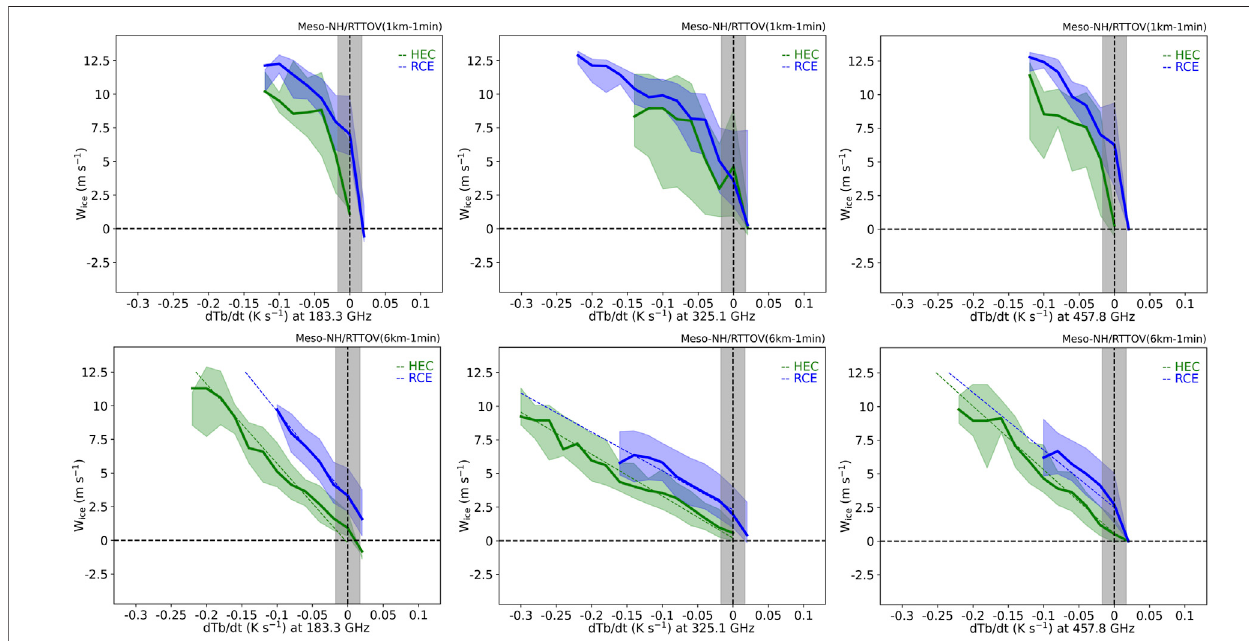
FIGURE 10| Same as Figure 8 butfor w ice . Results are shown for grid points verifyingthe growing core criterion. The least squares regressions (dashed lines) are shown for the 6-km resolution only.